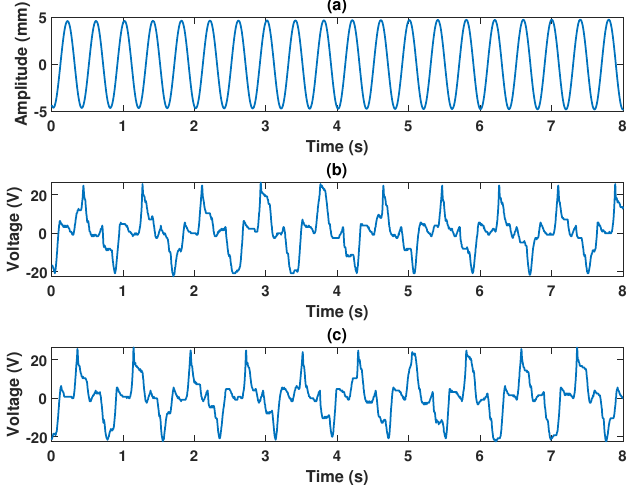
Figure 14. ( a ) External excitation input; ( b ) voltage versus time before 10,000 cycles; and ( c ) voltage versus time after 10,000